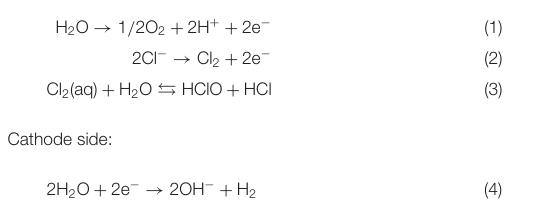
Supplementary Figure S2 | Flowchart for exploring the effects of AEW, MNZ, and Lifukang on microbial inactivation. Flow diagram showing experiments designed to determine sanitization potency of AEW, MNZ, and Lifukang on pure cultures of GS and LA treated for 5min, 10min, and 20min. Supplementary Figure S3 | Comparison of antibacterial rate of 20 ppm AEW, Lifukang, MNZ to LA and GS. The picture showed the antibacterial rate of 20 ppm AEW, Lifukang, and MNZ for LA and GS in different periods. Supplementary Figure S4 | Investigating bacterial staining by PI and Hoechst using fluorescence microscopy after AEW (20 ppm) treatment. Fluorescence labeled with Hoechst (blue) (A) and PI (red) (B) indicated bacterias with increased cell membrane permeability (indicated by arrows). Supplementary Figure S5 | Exploring ROS production in GS and LA using fluorescence microscopy after AEW (20 ppm) treatment. Representative DCF fluorescence of ROS in GS and LA was observed under a fluorescence microscope after 20 ppm AEW treatment (indicated by